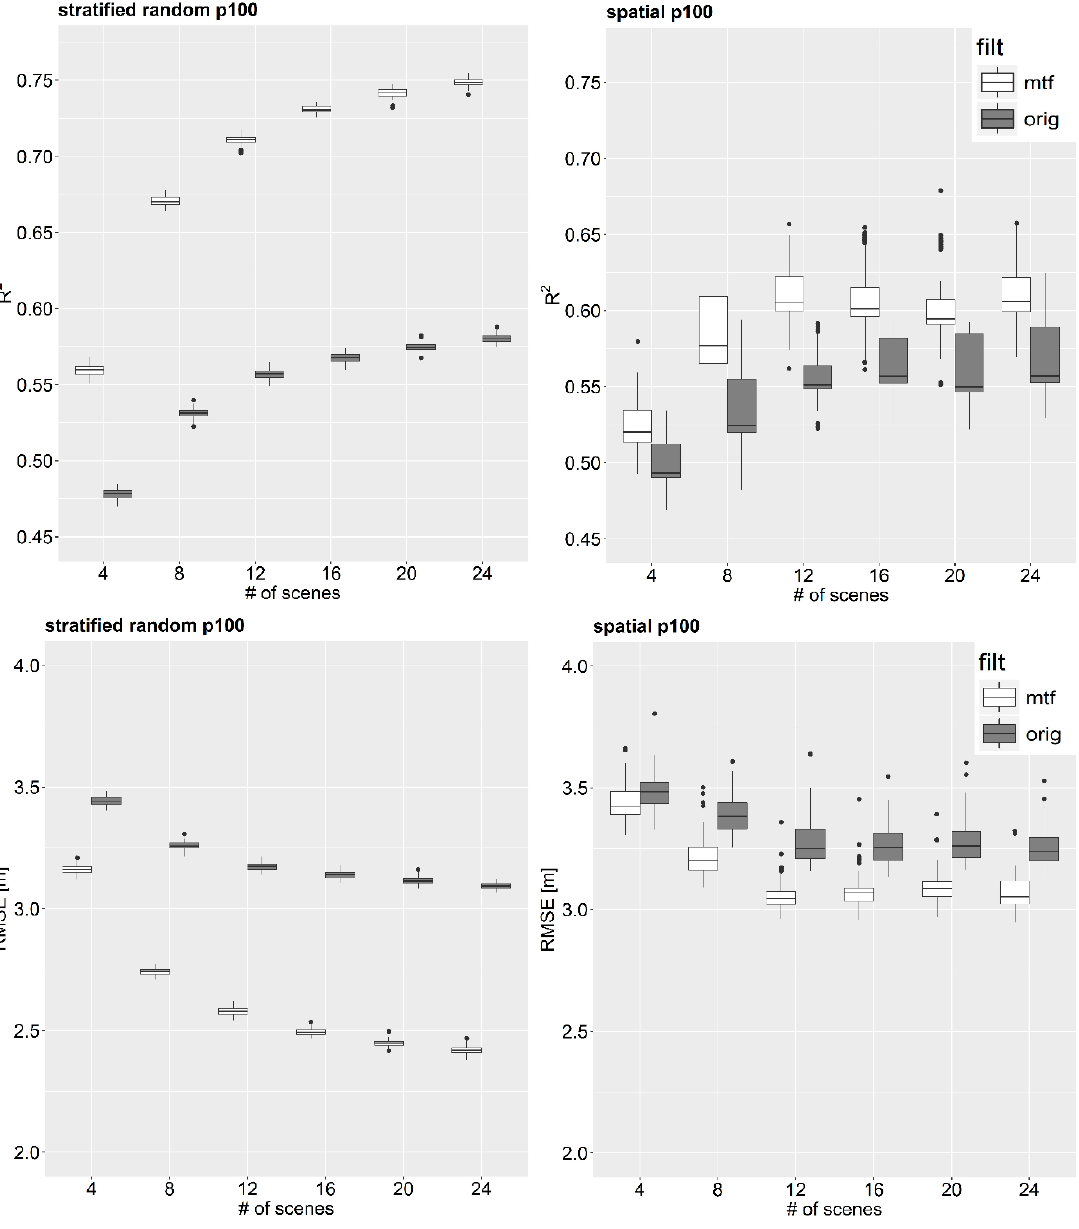
Figure 9. Impact of number of scenes on model prediction performance using “stratified random sampling” ( left ) and “spatial sampling” ( right ) for multi-temporal Quegan speckle-filtered data (“mtf”, white boxplots) and unfiltered ScanSAR data (“orig”, dark-grey boxplot).